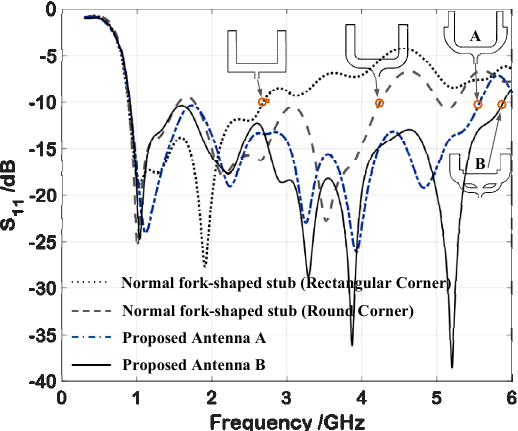
Figure 6. Simulated reflection coefficients of the proposed antennas, compared with the normal WS antenna.